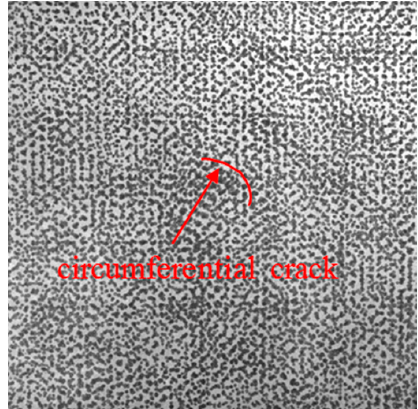
Figure 10. Variation of ε 1 at various points on the x and y axes at different moments in case of equal biaxial compression: ( a ) x axis direction; ( b ) y axis direction.